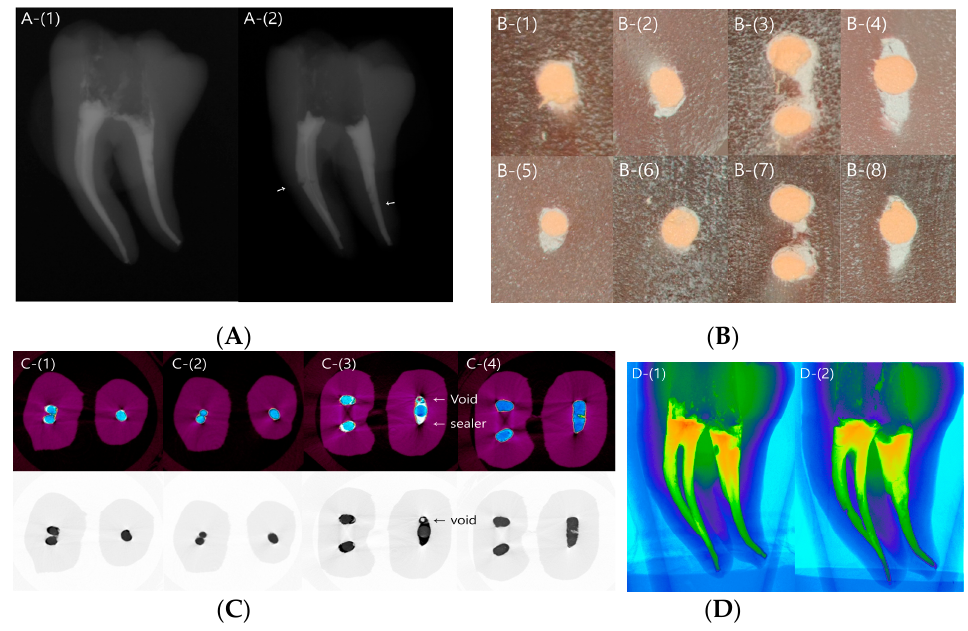
Figure 2. Microscopic and microcomputed tomography (micro-CT) images of the representative specimen. ( A ) Radiographic images after canal obturation using the single-cone (SC) (left panel) and continuous wave (CW) (right panel) techniques. Void formation is visible (arrow). ( B ) Microscope images in the sectioned area in (1) the apical area of the mesial canal in the SC group, (2) the apical area of the distal canal in the SC group, (3) the coronal area of the mesial canal in the SC group, (4) the coronal area of the distal canal in the SC group, (5) the apical area of the mesial canal in the CW group, (6) the apical area of distal canal in the CW group, (7) the coronal area of the mesial canal in the CW group, and (8) the coronal area of the distal canal in the CW group. ( C ) Representative micro-CT tomography images. The upper row is color-coded to distinguish the sealer from the gutta percha (GP). The sealer, void, and gutta percha are marked by an arrow. The image shows (1) the apical area in the single-cone (SC) group, (2) the apical area in the continuous wave (CW) group, (3) the coronal area in the SC group, and (4) the coronal area in the CW group. ( D ) Three-dimensional reconstructed images. In the mesial canal, the SC and CW groups are generally packed well. In the distal canal, voids are visible in the coronal area in the SC group (1), and some loosely packed areas are visible in the CW group (2).